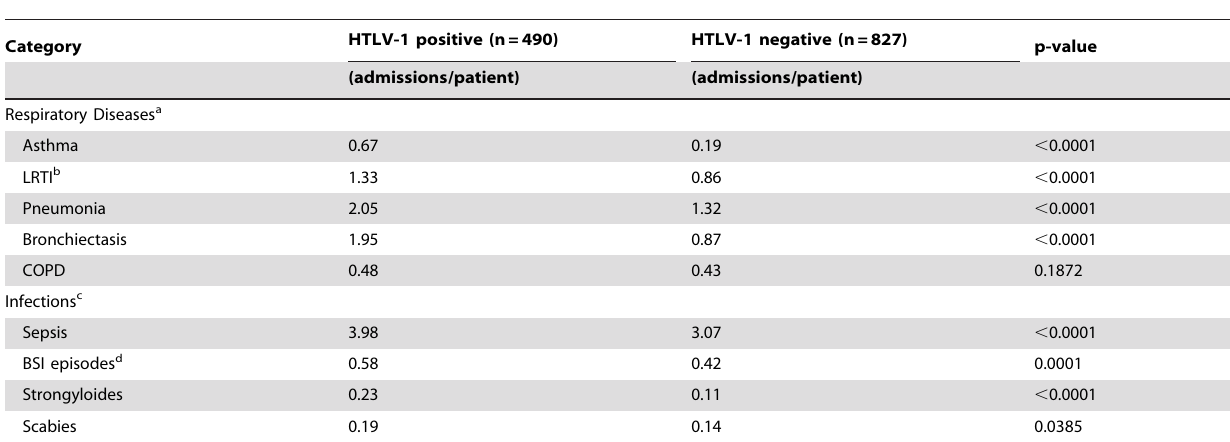
Table 4. Admission rates for respiratory conditions and other infections according to HTLV-1 serostatus.